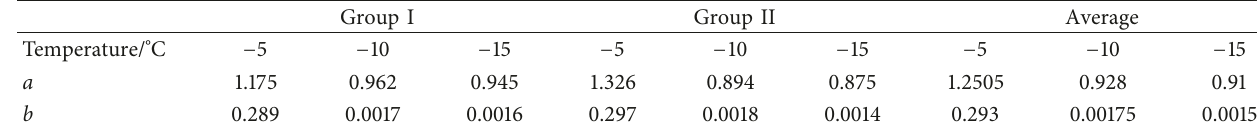
Table 4: Values a and b from test data fitting.